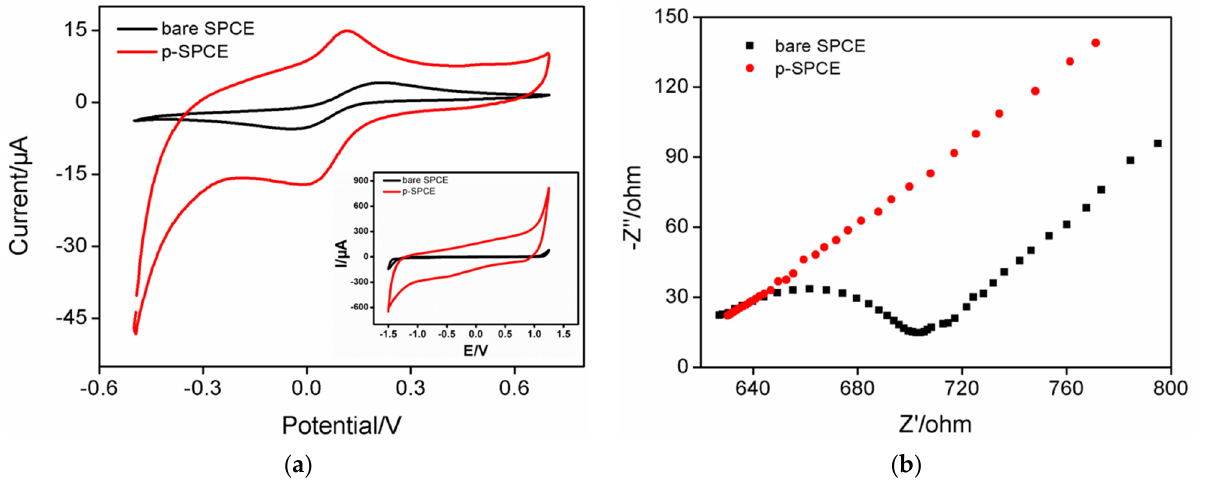
Figure 2. ( a ) CV curves obtained using different electrodes in 0.05 M KHP solution containing 0.5 mM Fe(CN) 63+ . Inset: CV curves obtained with SPCE or p-SPCE in PBS (0.1 M, pH = 6). ( b ) Nyquist plots of different electrodes obtained in 0.1 M KCl solution containing 2.5 mM K 3 Fe(CN) 6 and 2.5 mM K 4 Fe(CN) 6 .